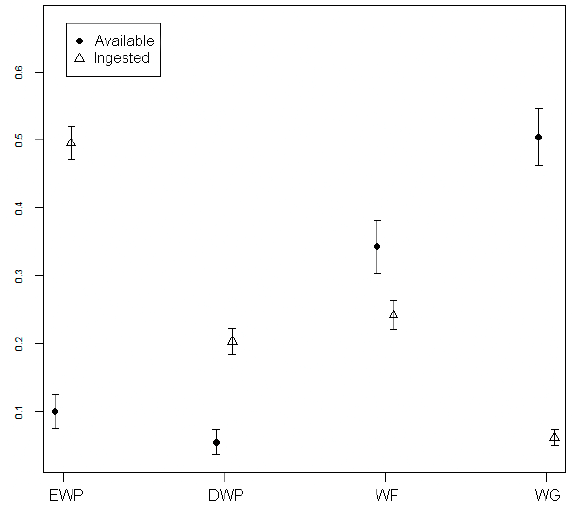
Figure 2. Ingested and available plants grouped by vegetation form in DS (EWP = Evergreen woody plants; DWP = Deciduous woody plants; WF = Wild forbs; WG = Wild graminoids).